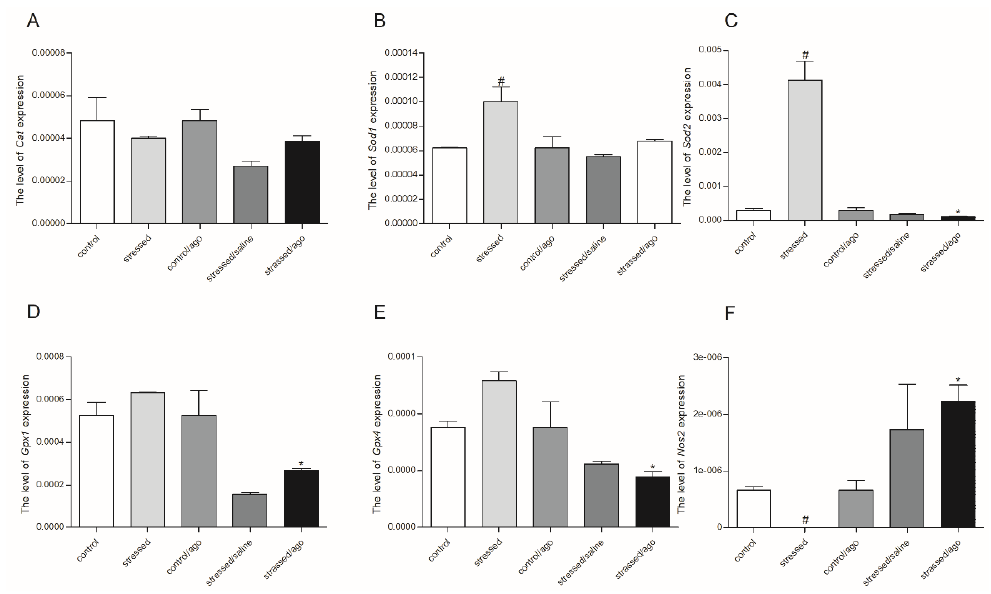
Figure 1. CAT - catalase ( A ) SOD1 – superoxide dismutase 1 ( B ), SOD2 – superoxide dismutase 2 ( C ), Gpx1 – glutathione peroxidase 1 ( D ), Gpx4 - glutathione peroxidase 4 ( E ), and NOS2 nitric oxide synthetase 2 ( F ) mRNA expression in peripheral blood mononuclear cells (PBMCs) of rats exposed to chronic mild stress (CMS) procedure for two weeks (Control, Stressed) and in animals exposed to CMS for seven weeks and administered vehicle (1 mL / kg) or agomelatine (10 mg / kg) for five weeks (Control / Ago, Stressed / Saline, Stressed / Ago). Relative mRNA expression was calculated using a 2 − ∆ Ct (Ctgene–Ct18S) method. Data were presented as means ± SEM. N = 6. * p < 0.05 for di ff erences between stressed and stressed / ago groups, and # p < 0.05 for di ff erences between controls and stressed